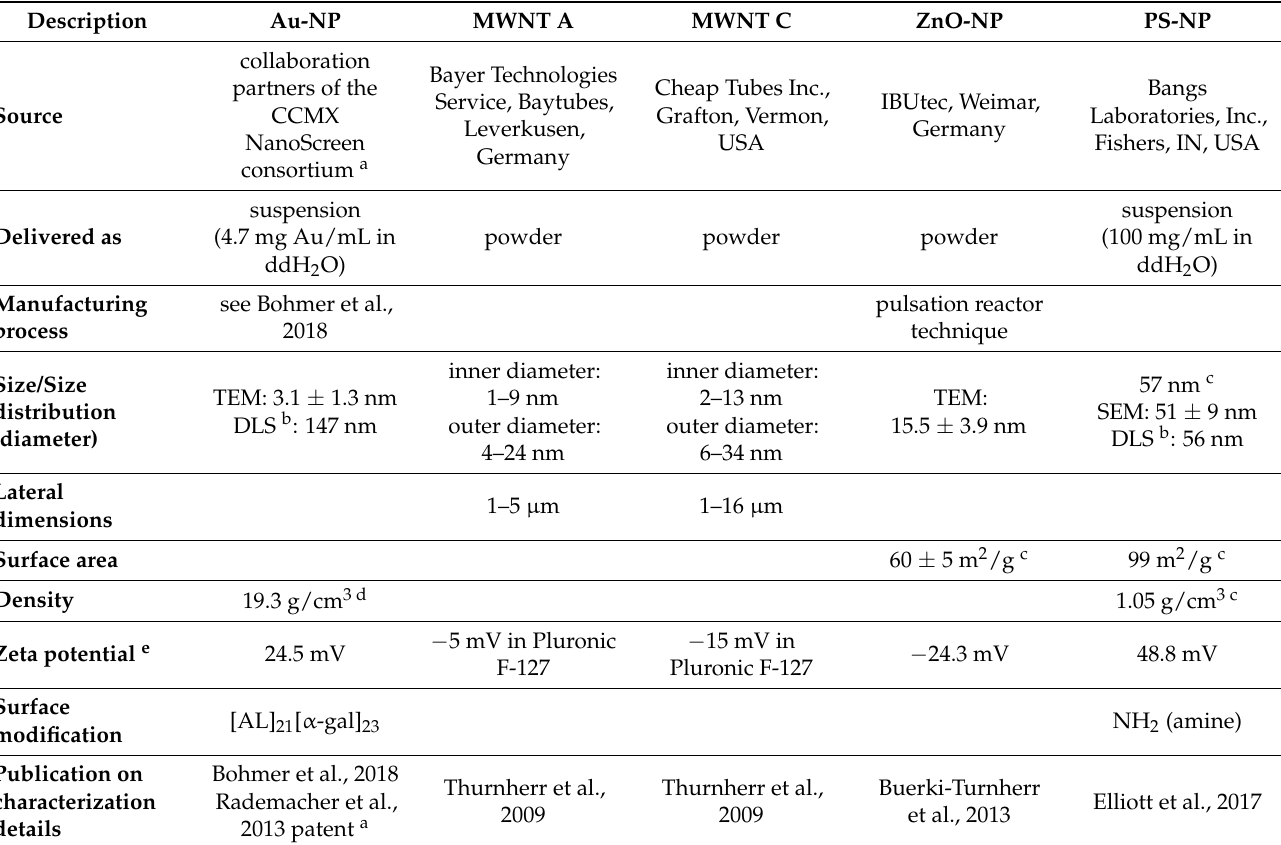
Table 2. Characteristics of cytotoxic